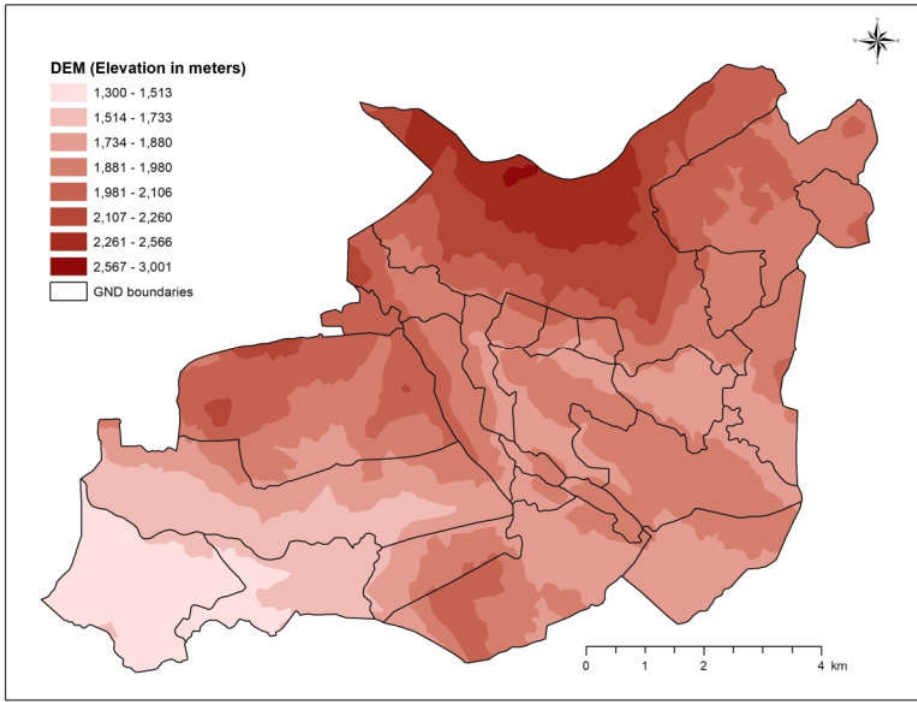
Figure 4. Elevation distribution of the study area.